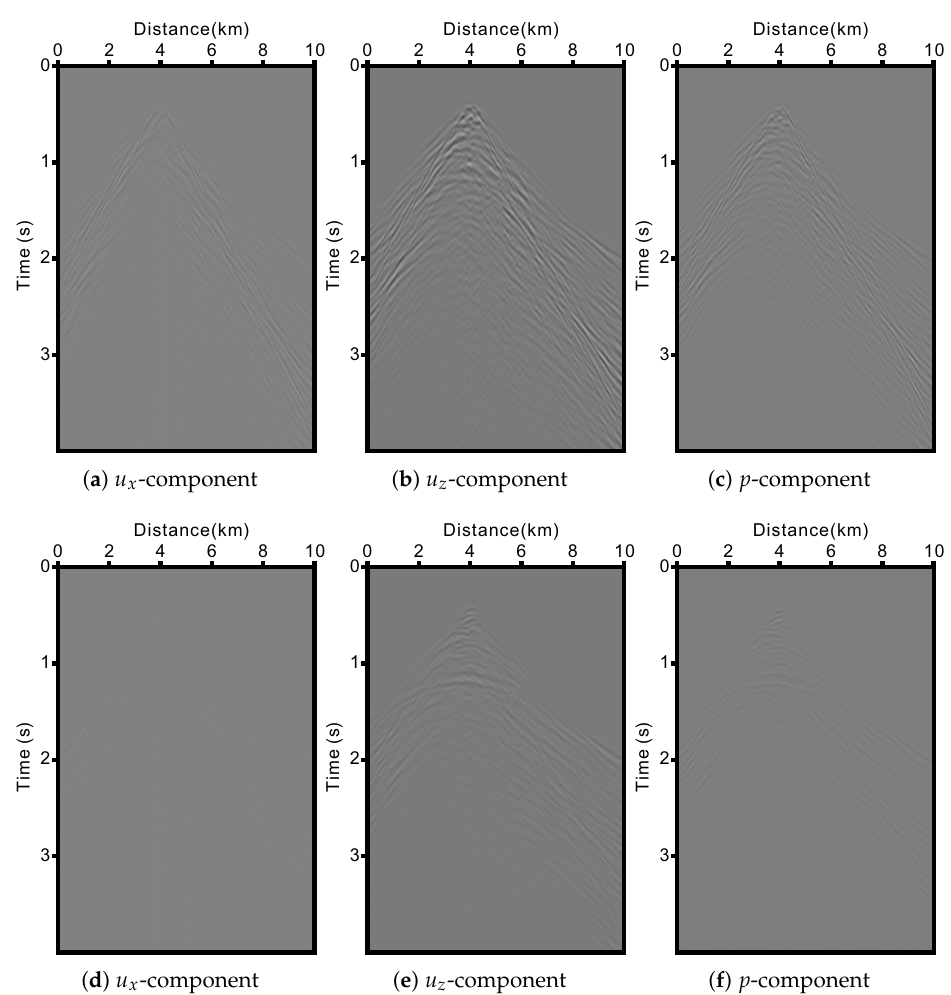
Figure 9. Multicomponent data residuals obtained by inverted models in Figure 7. The scale is consistent with the shot gathers in Figure 5 seismic data. ( a – c ) The residuals of PCG and ( d – f ) the residuals of